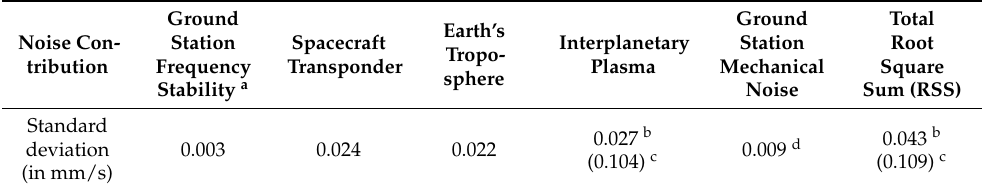
Table A1. EnVision Doppler noise budget breakdown (two-way X/X-Ka Doppler measurements at 10 s count